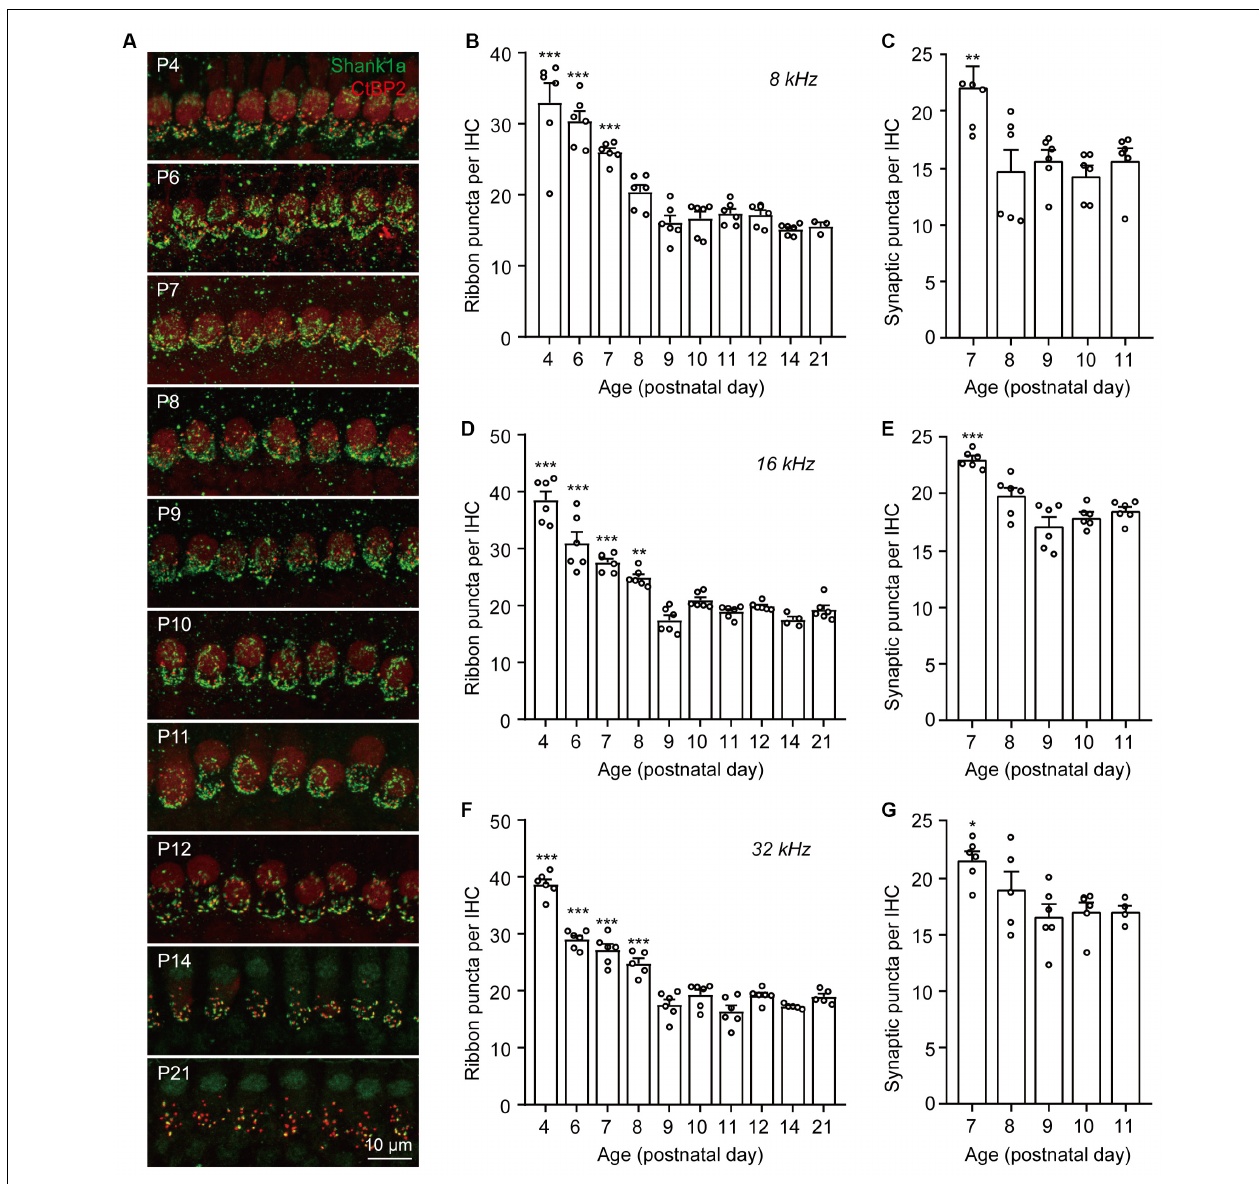
FIGURE 1 | Dynamic changes of IHC ribbon synapse densities during postnatal development. (A) Representative images of presynaptic and postsynaptic specializations from inner hair cells at different postnatal ages. The images were taken at the middle cochlear frequency (16 kHz). Synapses within the entire length of the images were counted. (B–G) Quantitative analyses of synaptic ribbon counts (B,D,F) and putative ribbon synapses (C,E,G) at 8 kHz (B,C) , 16 kHz (D,E) , and 32 kHz (F,G) cochlear regions. N = 3–6, error bars represent mean ± SEM. (B,D,F) ** p < 0.01 and *** p < 0.001 comparing to data at P21; (C,E,G) * p < 0.05, ** p < 0.01 and *** p < 0.001 comparing to data at P11 by one-way